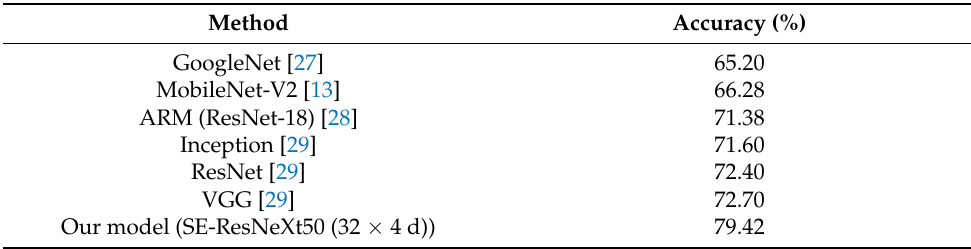
Table 5. Average accuracy of the Fer2013 public benchmark.